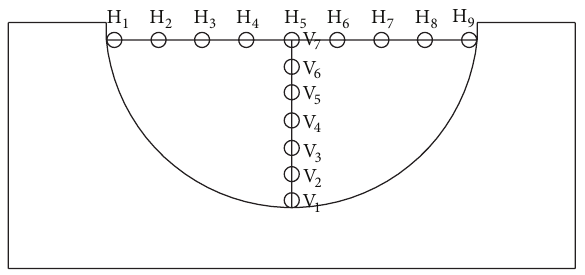
Figure 5: Layout of measurement